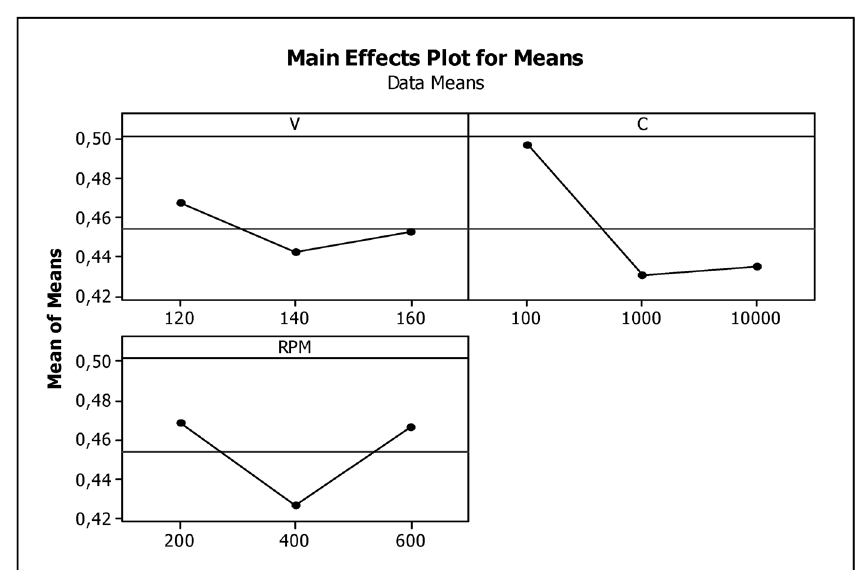
Figure 5: In fl uence of process parameters on P i in Deng ’ s method.